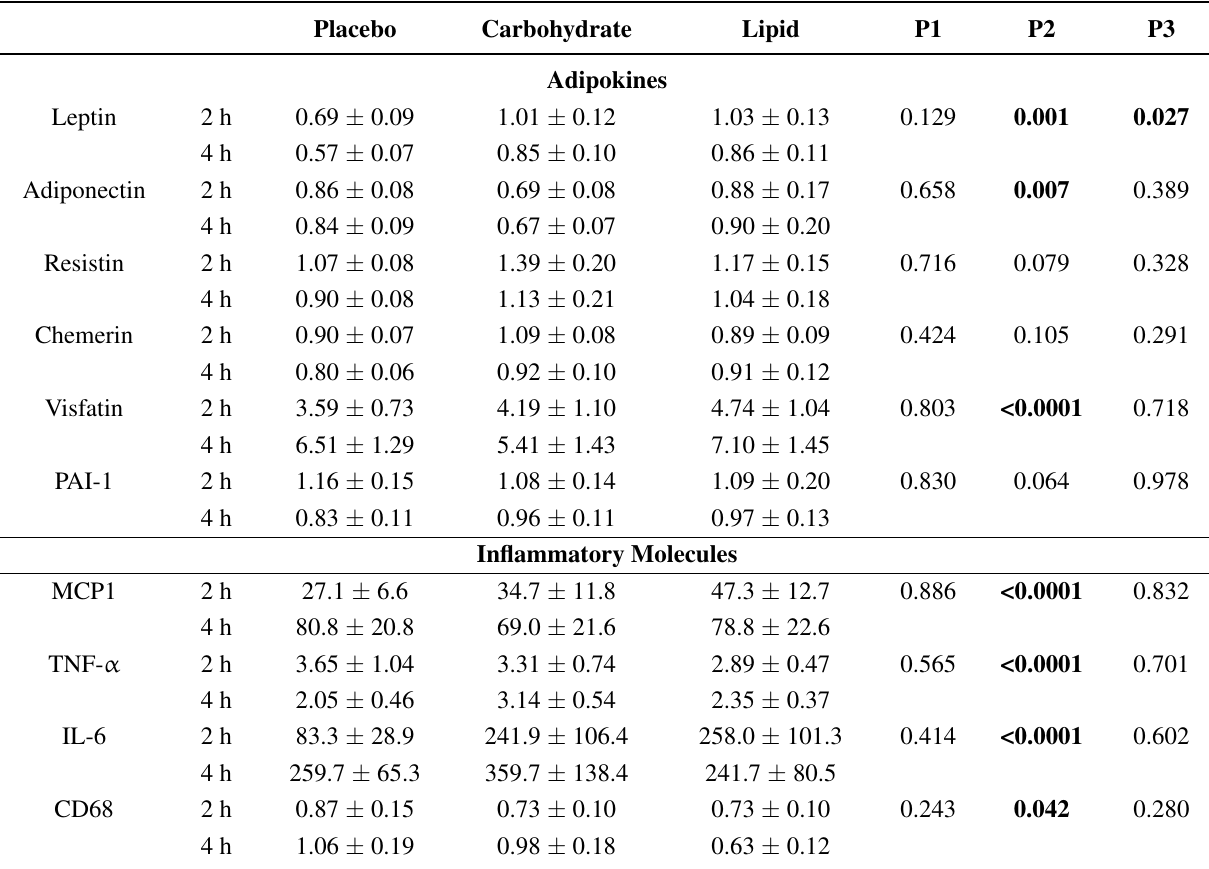
Table 2. Adipose tissue reverse transcription polymerase chain reaction (RT-PCR)—Fold change from